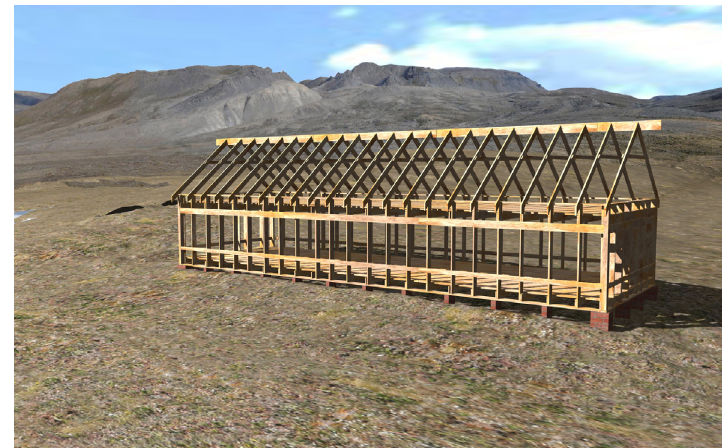
Figure 8. Computer model of the Greely station house under